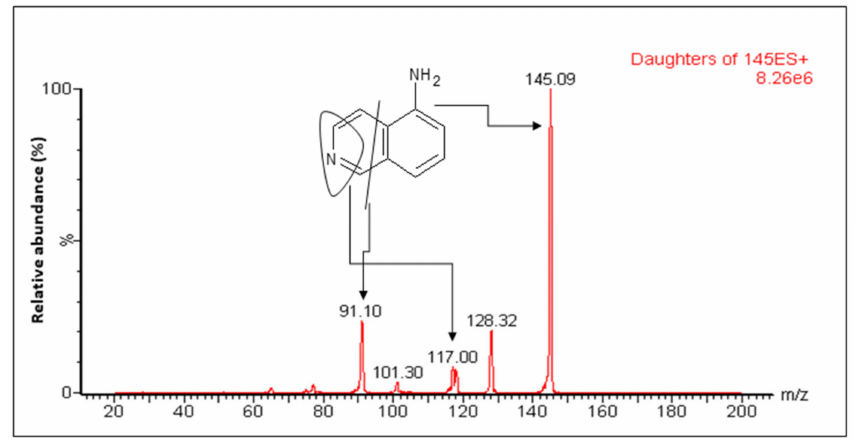
Figure 1. Representative precursor to product ion ( m / z ) transition of 5-AIQ in ESI positive